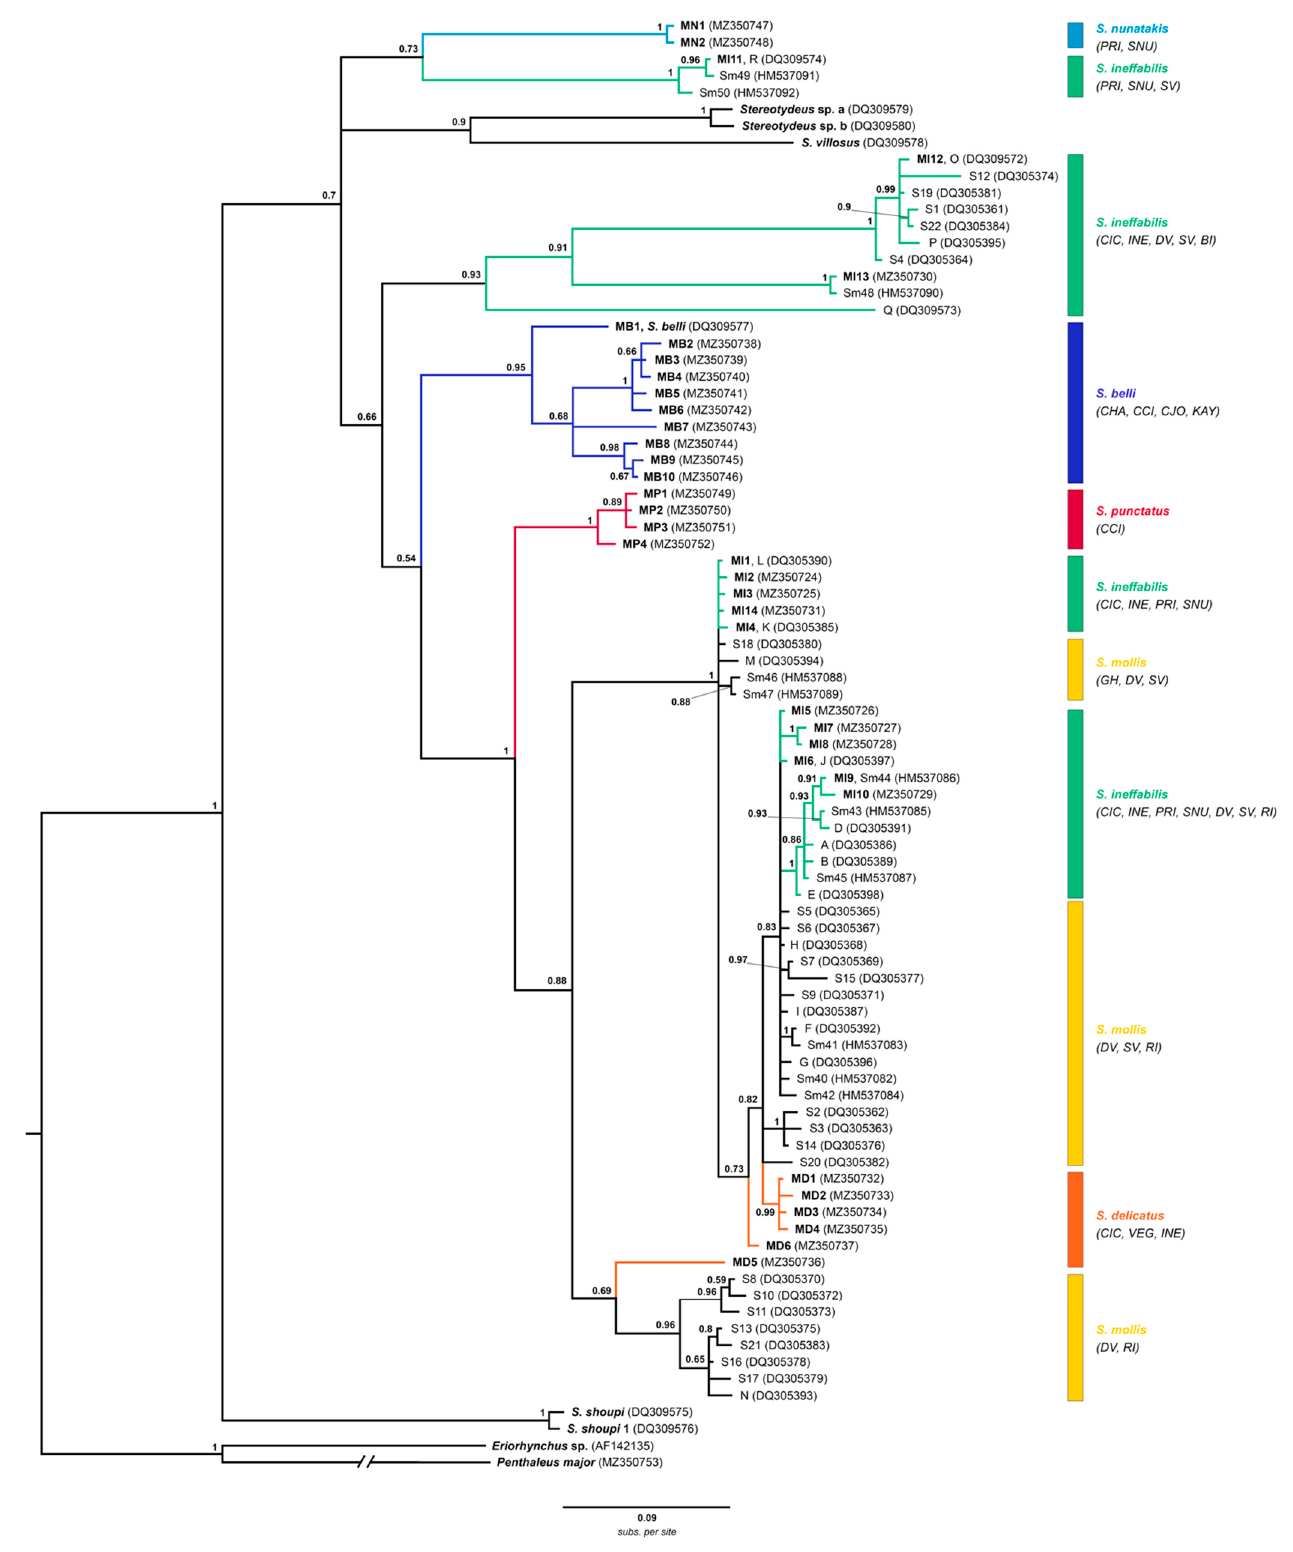
Figure 4. Phylogenetic tree of cox1 haplotypes of Stereotydeus specimens from Victoria Land and the McMurdo and southern Dry Valleys [33,34,36]. Posterior probabilities are shown at the nodes. New haplotypes (in bold): labels indicate the ID of the haplotype; accession numbers are shown in brackets.